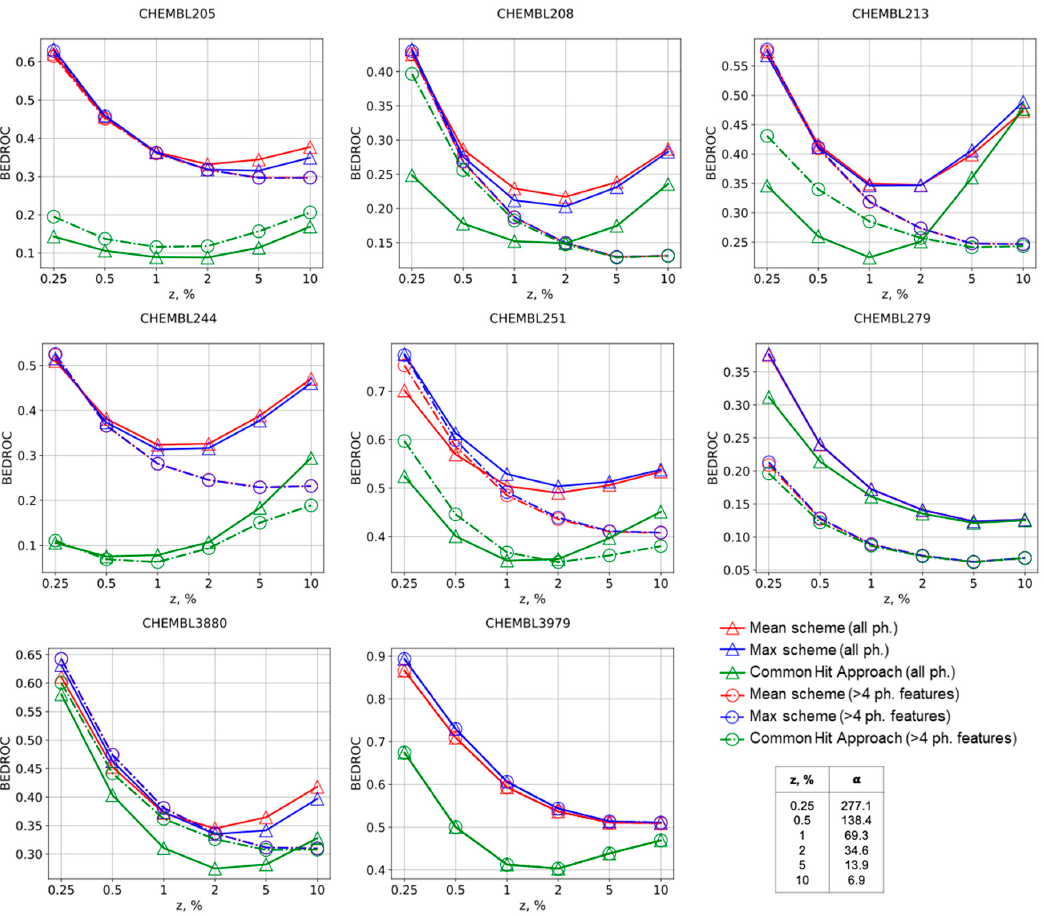
Figure 2. BEDROC curves for the Max, Mean, and CHA schemes of molecules ranking in virtual screening for selected targets. The numbers of corresponding ChEMBL targets are provided.